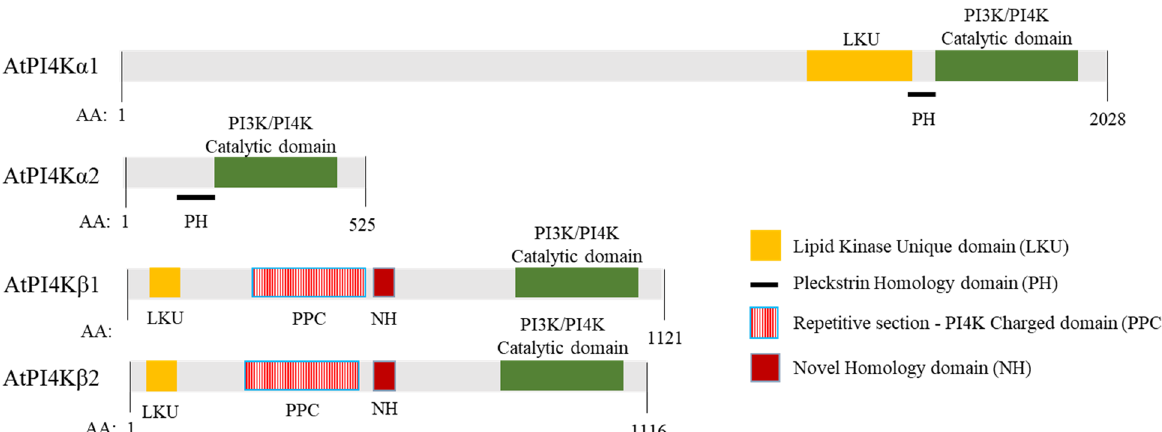
Fig. 2 Domain architectures and multiple sequence alignment of Arabidopsis thaliana phosphatidylinositol 4- kinases. PI4Ks are characterized by a predicted catalytic domain, and are divided into three groups: alpha (α), beta (β), and gamma (γ), based on additional domains. The α and β groups, with the exception of AtPI4Kα2, have a lipid kinase unique (LKU) domain or the helical domain. The β group members have a novel homology (NH) domain, and also contain an N-terminal LKU domain. Both α and β groups contain a PtdIns-binding domain, Pleckstrin Homology (PH) and Pi4K charged (PPC) domain,